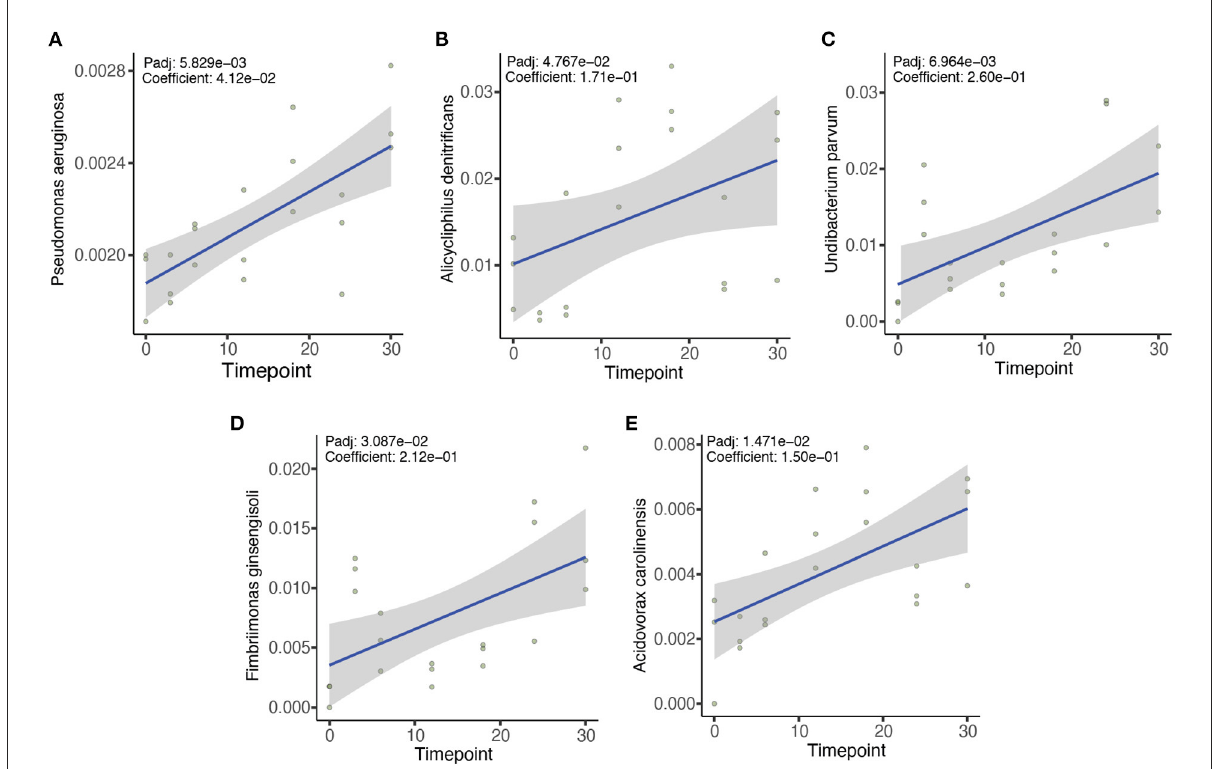
FIGURE4 Five most significant associations between microbial species and the duration of OTC exposure. MaAsLin2 was used to evaluate the association between different microbial taxa with the duration of OTC exposure. We identified numerous positive and negative associations between the microbes and OTC exposure (Supplementary Table 4). However, Pseudomonas aeruginosa (A) , Alicycliphilus denitrificans (B) , Undibacterium parvum (C) , Fimbriimonas ginsengisoli (D) , and Acidovorax carolinensis (E) showed the strongest positive associations. Benjamini and Hochberg false discovery rate (FDR) controlling procedure was performed for the correction of P- values ( P adj) and only P adj < 0.1 were considered statistically